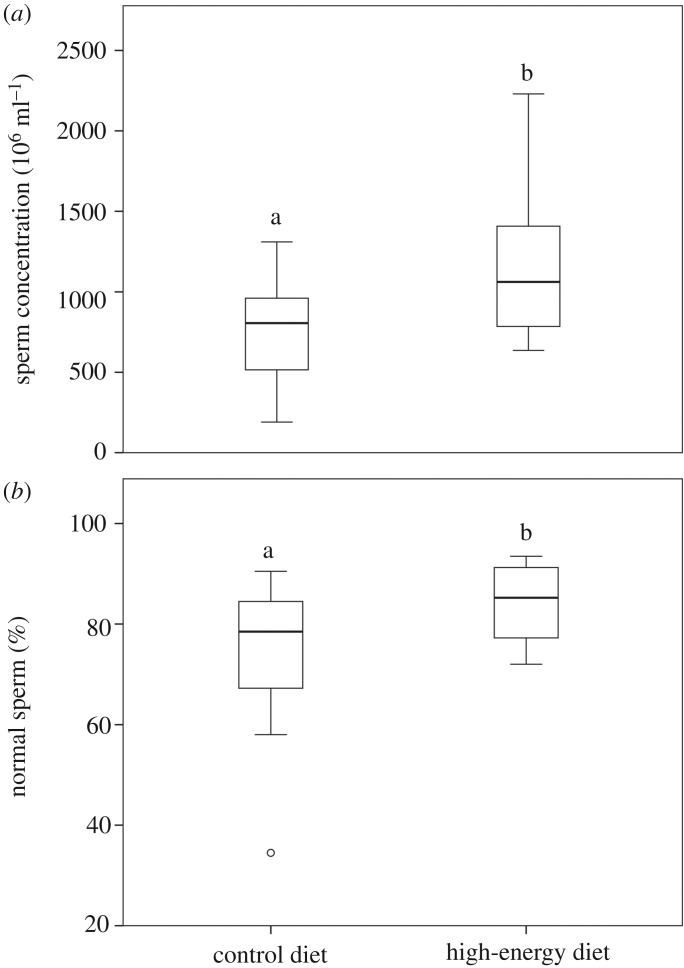
(a) Sperm concentration and (b) normal sperm morphology of fallow deer yearlings fed with pasture (control diet, for sperm concentration, N = 15; for sperm morphology, N = 16) or pasture with barley grain supplementation (high-energy diet, N = 16). Different letters above the box plots indicate significant differences between groups (p < 0.05).